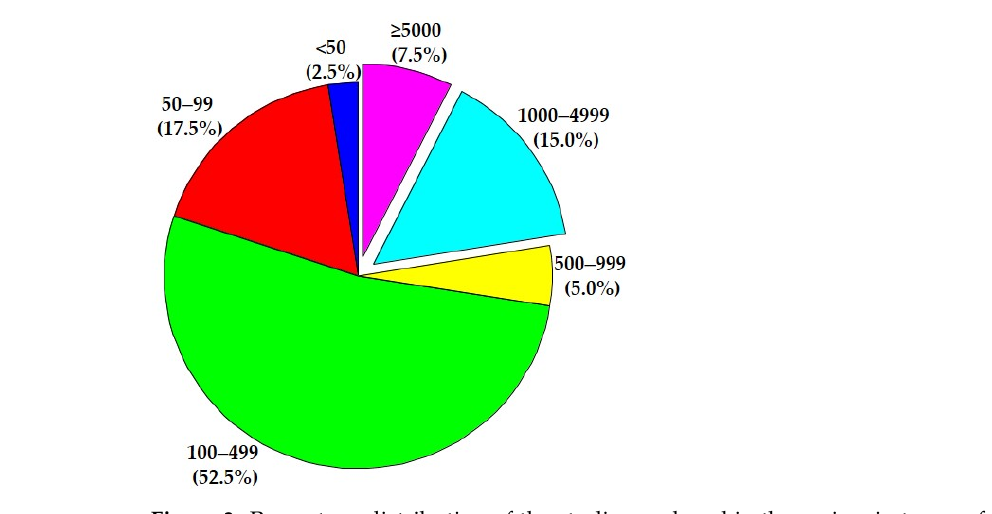
Figure 3. Percentage distribution of the studies analyzed in the review in terms of the size of the study cohorts (from minimum of <50 subjects to maximum of ≥ 5000 subjects).